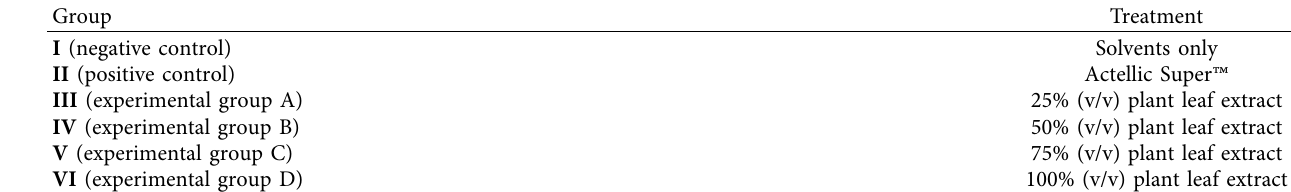
Table 1: Treatment protocol for determination of contact toxicity effects.